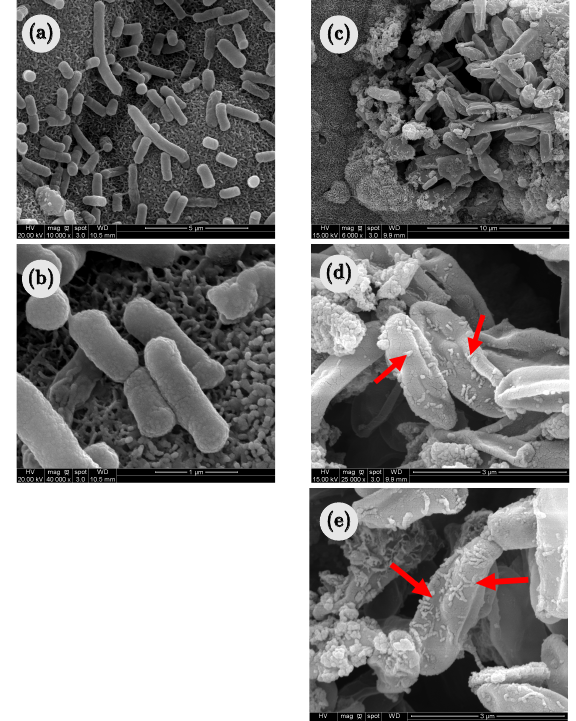
Figure 8. SEM images (secondary electron mode) of intact cells on control-coated samples kept in the dark ( a , b ) and of damaged cells observed on TiO 2 -coated samples irradiated with UV light for 24 h experiment ( c , d , e